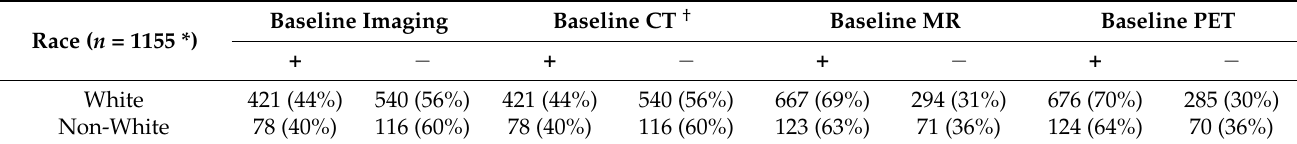
Table 2. Baseline assessment of patients.